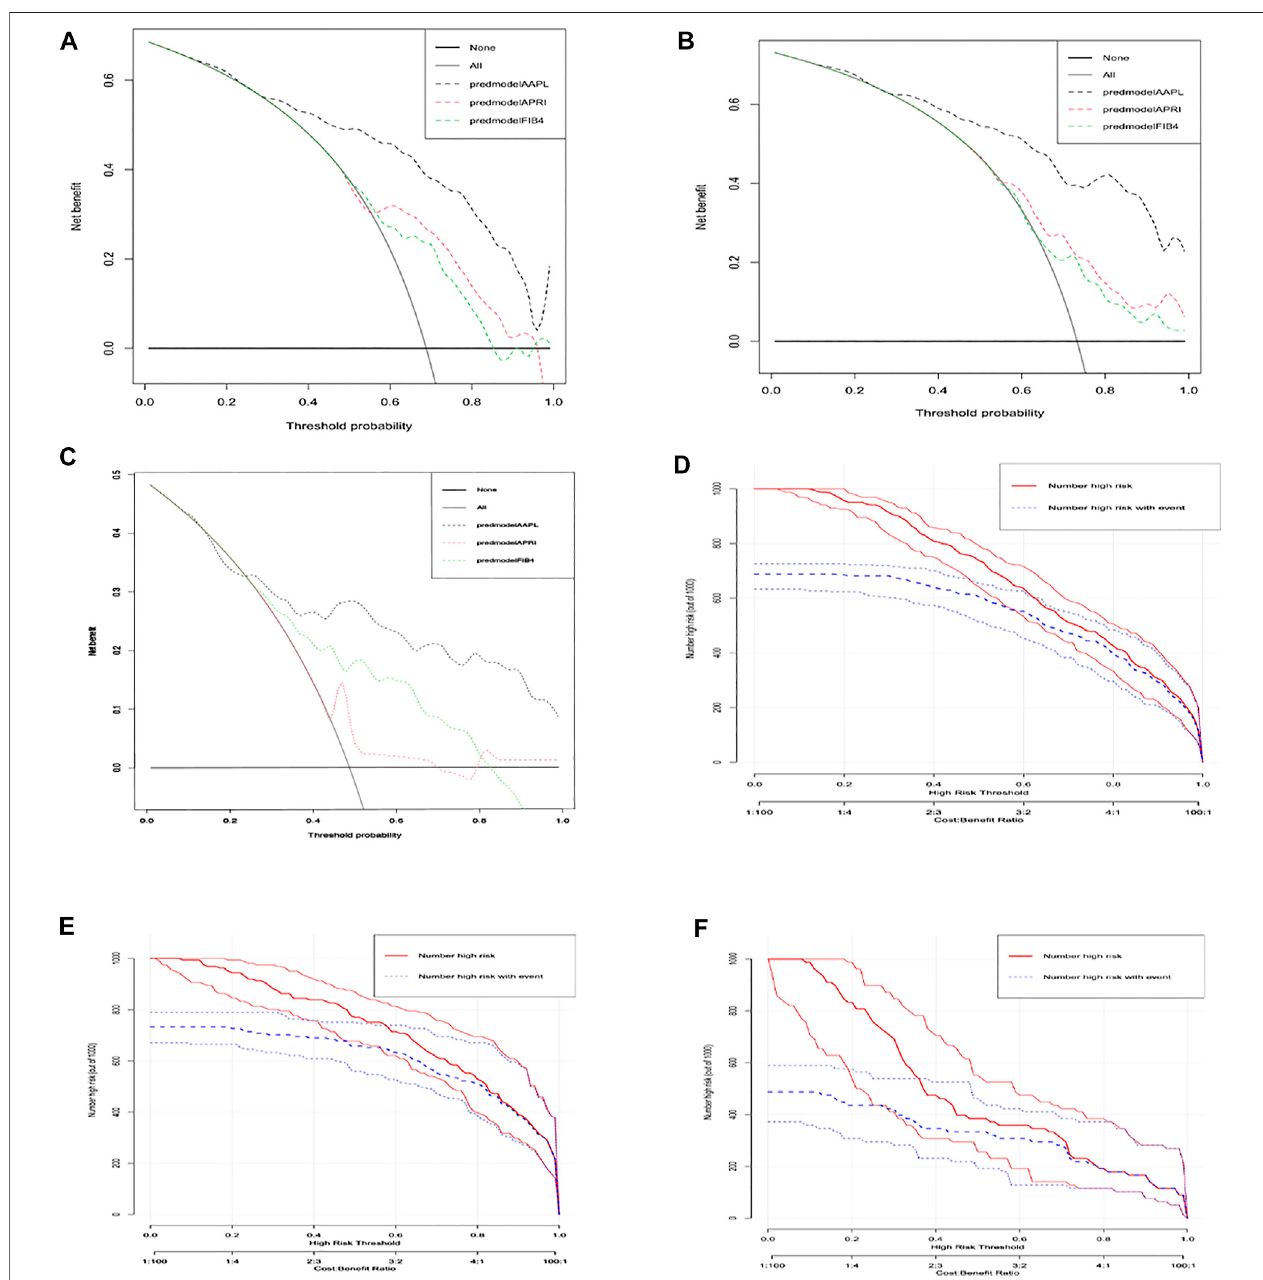
FIGURE 3 | Decision curve analysis (DCA) and clinical impact curve analysis (CICA) of the AAPL nomogram (ALT, AST, PTA, and LSM). DCA of the AAPL nomogram for predicting signi fi cant fi brosis in patients with CHB in the (A) development cohort, (B) internal validation cohort, and (C) independent validation cohort. CICA of the AAPL nomogram for predicting signi fi cant fi brosis in patients with CHB in the (D) development cohort, (E) internal validation cohort, and (F) independent validation cohort.